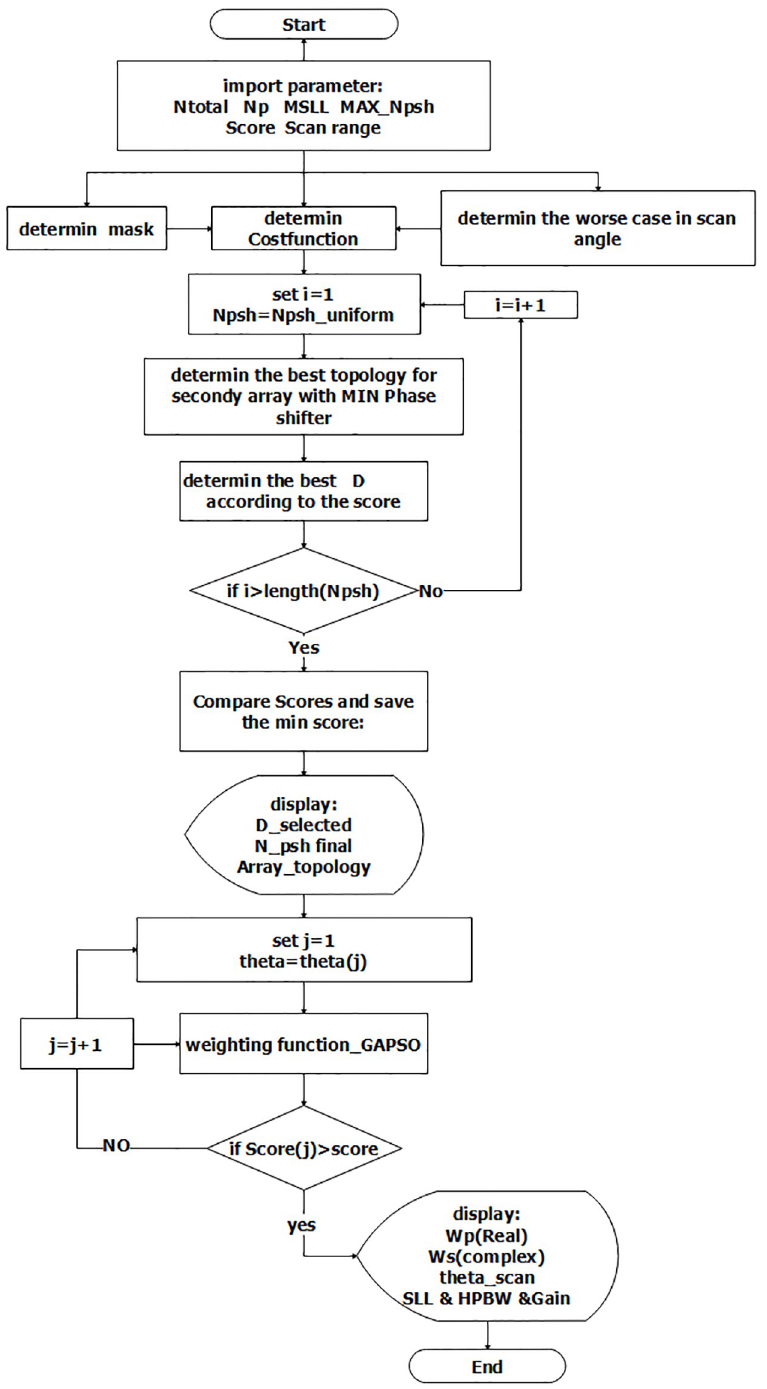
Fig 2. Guideline of the proposed